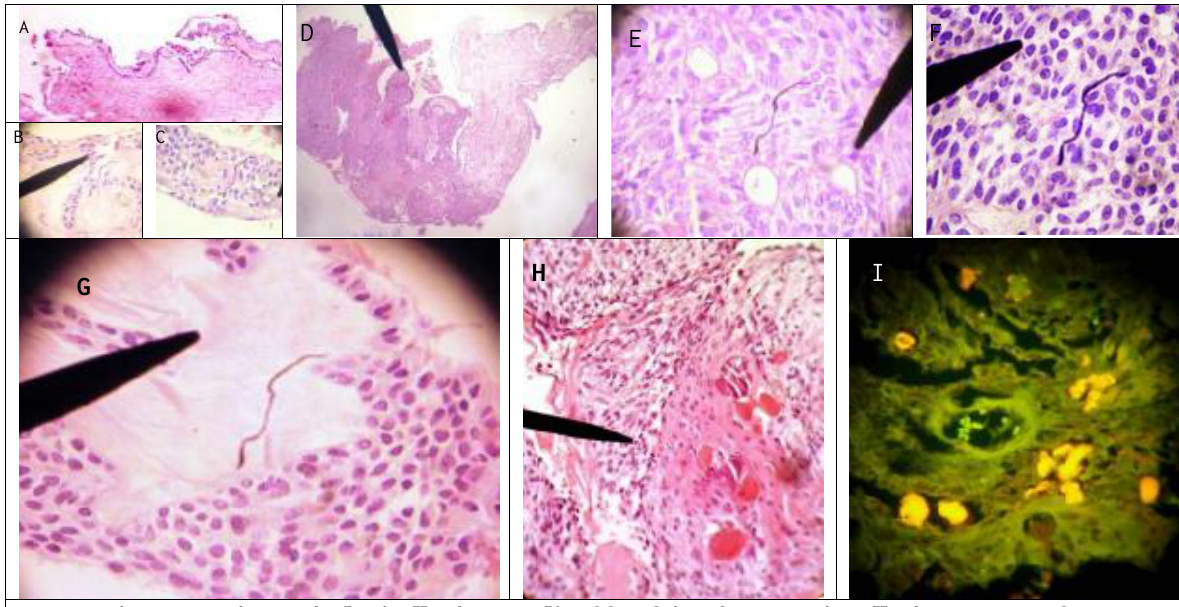
Figure 2: Histopathologically the cyst lined by thin odontogenic cells that surround a fibrovascular stroma (A). The epithelial cells extend as strands intramurally or show thinking with hyalinization (B &C), beside an area of nodular proliferation (D arrow). The proliferating cells revealed: few duct-like structures (E), polygonal clear cells with nuclear hyperchromatism (F) and polymorphism (G), and foci intercellular and intraductal eosinophilic material (H). The amorphous material is amyloid. After staining withCongo red it appears bright orange under fluorescent light (I).(A and D, X10; remaining photomicrographs X40)